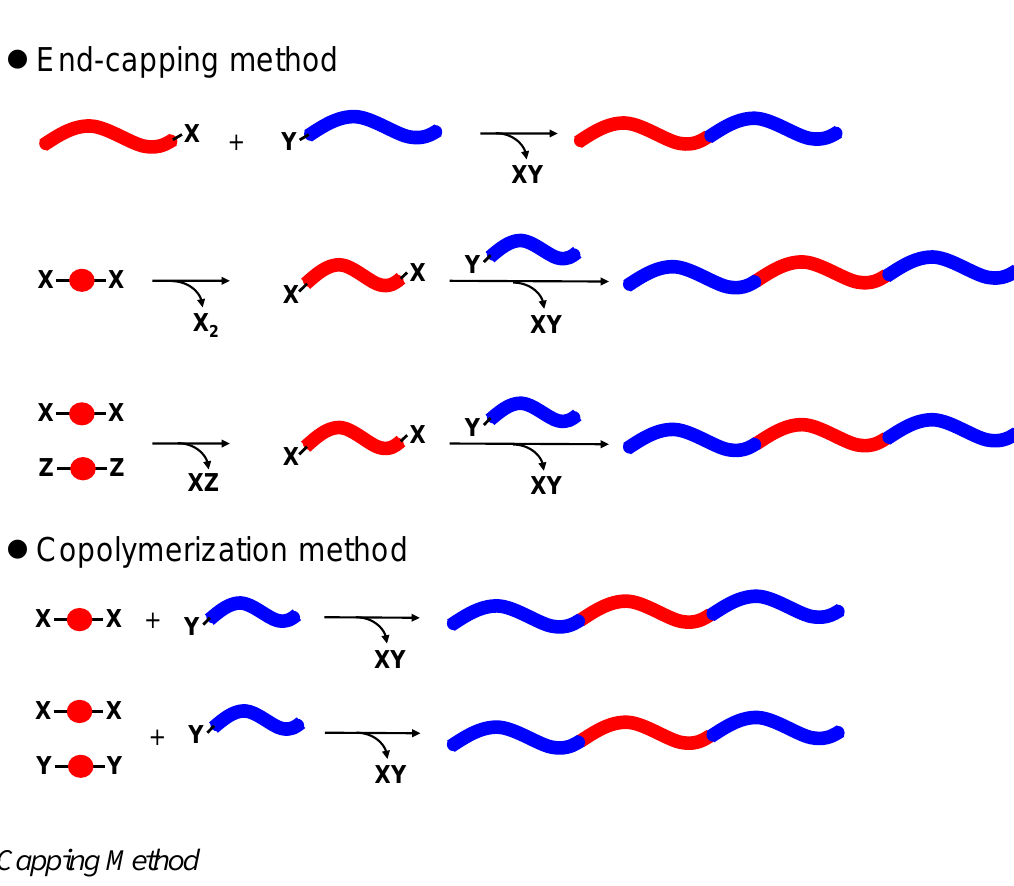
Figure 7. End-capping method and copolymerization